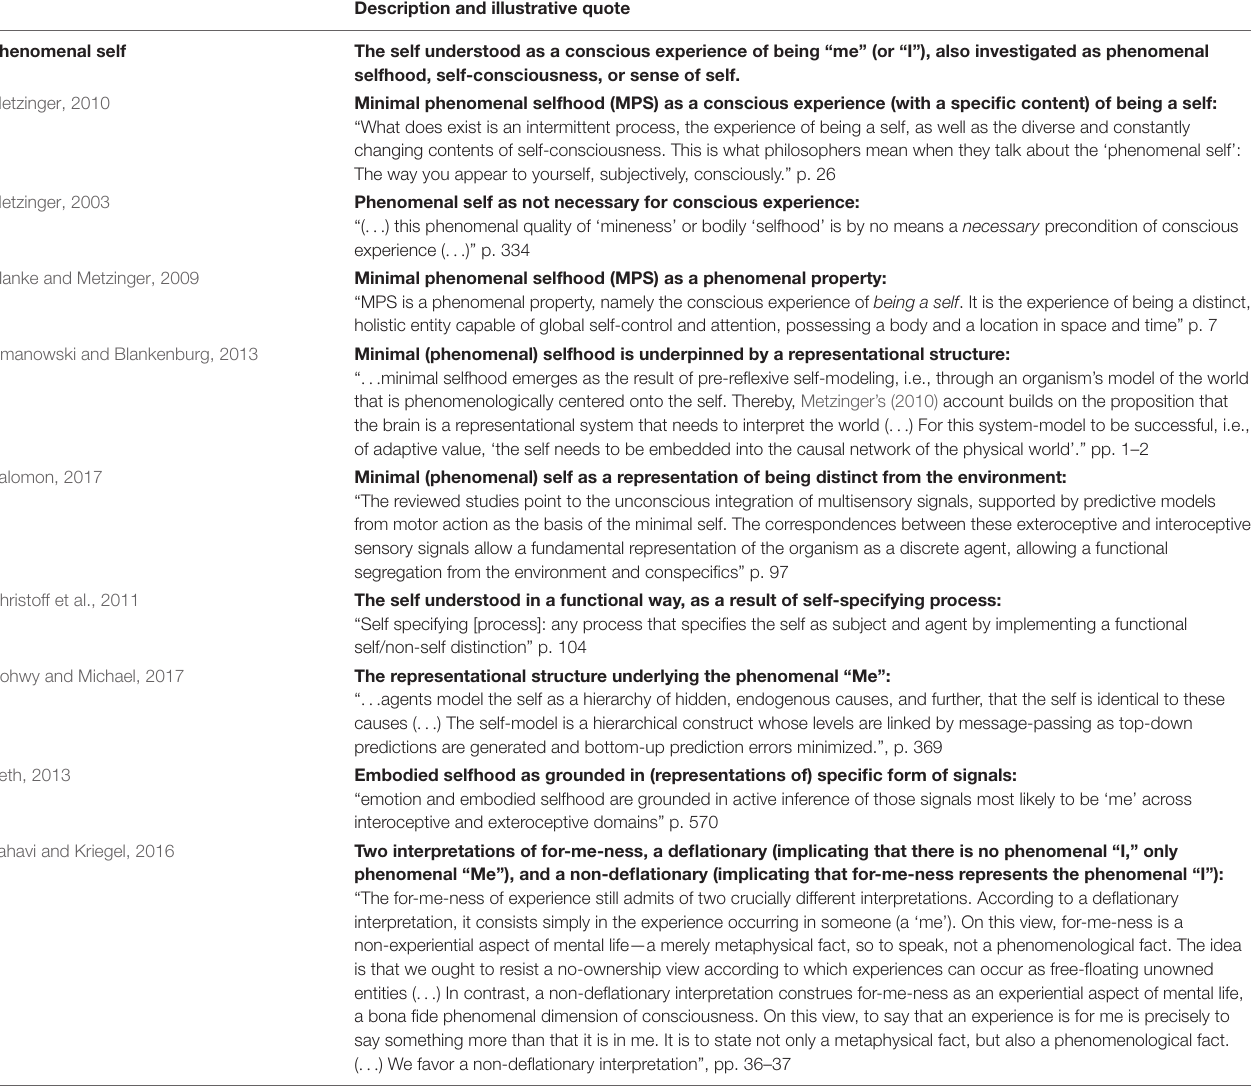
TABLE 2 | Examples of theories of the self-as-object (“Me”) in the context of consciousness, as theories of the phenomenal self, with representative quotes illustrating each